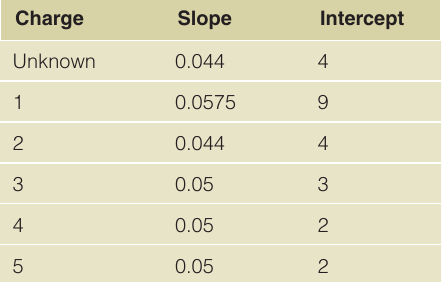
Table S1. Rolling Collision Energy settings of the TripleTOF